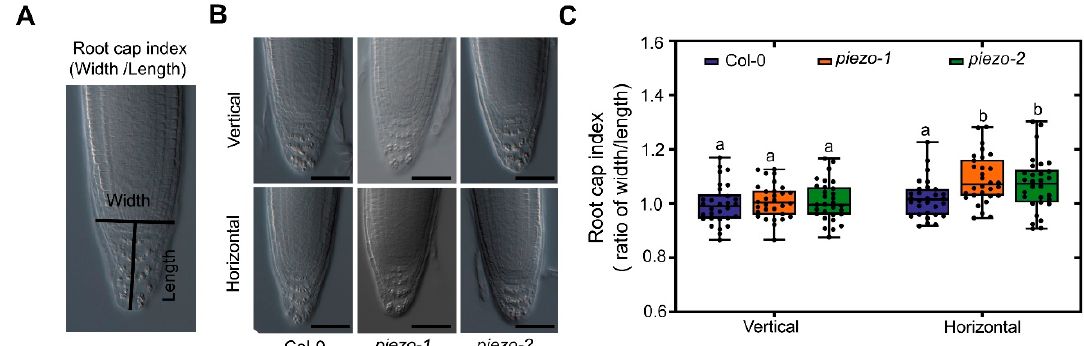
Figure 5. AtPiezo affects the shape of root caps in response to mechanical forces. ( A ) Schematic diagram of root cap index. The index is the ratio of the width across the QC and the length from QC to the root tip. ( B ) Root cap shape of Col-0, piezo1 , and piezo-2 grown on the medium with 0.8% agar. The root cap of 4-day-old plants that vertically grew on the agar medium (Vertical). The root cap of the plants that horizontally grew for 24 h followed by vertical growth for three days on the medium (Horizontal). Bar = 50 μ m. ( C ) Statistic analysis of root cap index for different plants under vertical and horizontal growth conditions. Boxplots span the first to the third quartiles of the data. A line in the box represents the median ( n = 30). The results were analyzed with two-way ANOVA and Tukey’s multiple comparison test (Different lowercase letters indicate significant differences at p < 0.05).